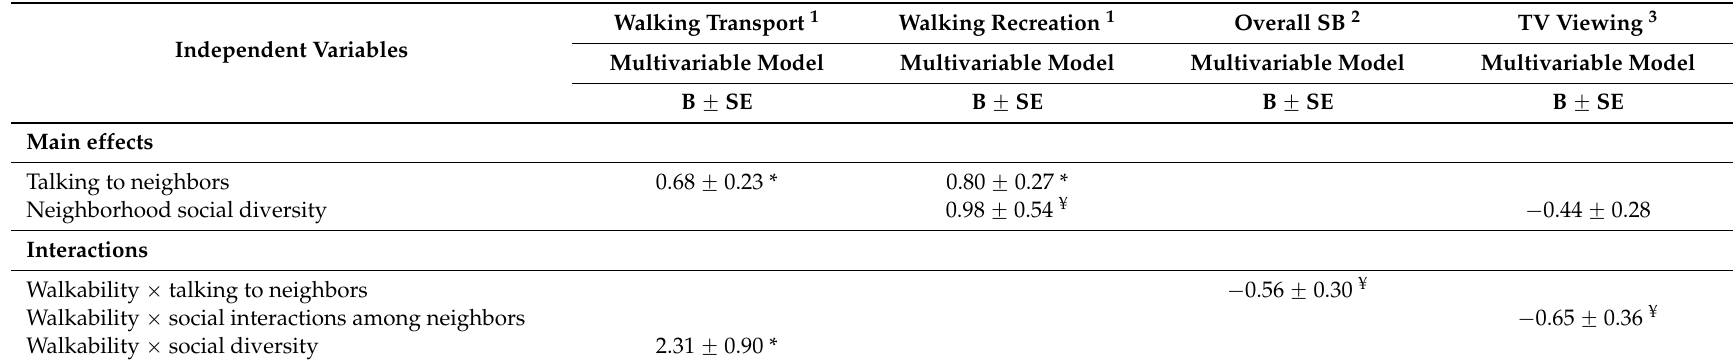
Table 3. Multivariable model for main associations between social environment factors and walking/SB, and moderating effects of